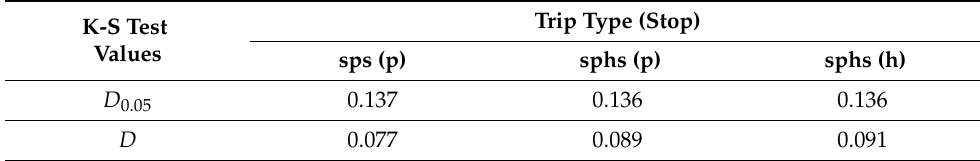
Table 5. Results of the Kolmogorov–Smirnov